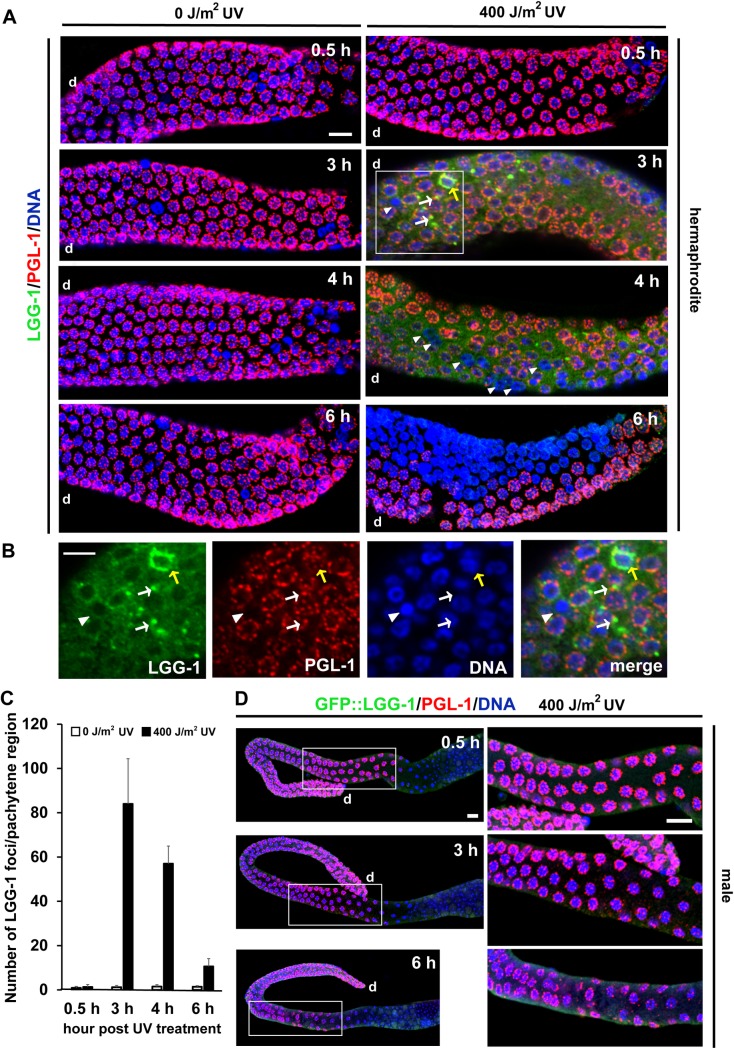
LGG-1 foci formation following UV irradiation in hermaphrodite and male gonads.(A) Confocal immunofluorescence images showing the time course of LGG-1 foci formation (green) and associated removal of PGL-1 (red) from germ nuclei (blue) in the pachytene region of N2 adult hermaphrodite gonads following 0 or 400 J/m2 of UV irradiation. More than 20 gonads were observed at respective time points under respective conditions. (0.5 h) Neither LGG-1 foci formation nor removal of PGL-1 was observed in the majority of germ cells in both the UV-irradiated and non-irradiated gonads. (3 h) A significant number of LGG-1 foci were observed in the cytoplasm and at the perinuclear region of germ cells (arrows in the inset), and PGL-1 started to disappear from some germ cells (an arrowhead in the inset) in the UV-irradiated gonad. The non-irradiated gonad appeared not different from the one at the 0.5 h time point. (4 h) The number of LGG-1 foci decreased compared to the 3 h time point, and PGL-1 was removed from a significant number of germ cells (arrowheads) in the UV-irradiated gonad. The non-irradiated gonad appeared not different from the ones at the 0.5 h and 3 h time points. (6 h) LGG-1 foci largely disappeared, whereas PGL-1 was lost from around 50% of germ cells (a cluster of blue germ nuclei) in the pachytene region of the UV-irradiated gonad. The non-irradiated gonad still appeared not different from the ones at the 0.5 h, 3 h, and 4 h time points. (B) The signals of LGG-1 (green), PGL-1 (red), and DNA (blue) in the inset (the area enclosed with a white square in the UV-irradiated 3 h gonad image) in (A) were enlarged and displayed separately along with their merged image for better appreciation of their localization and association in the area. The white arrows indicate LGG-1 foci that are located adjacent to PGL-1 granules. The yellow arrow indicates a cluster of LGG-1 foci that surround several PGL-1 granules. (C) Mean ± s.d. number of LGG-1 foci formed in the pachytene region of N2 adult hermaphrodite gonads at respective time points following 0 J/m2 (white bars) or 400 J/m2 (black bars) of UV irradiation. Number of analyzed gonads, n ≥ 20 for each time point and condition. (D) Confocal immunofluorescence images showing the equivalent time course of GFP::LGG-1 expression (green) and PGL-1 localization (red) in adult male gonads expressing a pie-1 promoter-driven GFP::LGG-1 transgene following 400 J/m2 of UV irradiation. Number of observed gonads, n = 15 for each time point. Left column, the entire gonads. Right column, enlarged pachytene region of respective gonads. Neither LGG-1 foci formation nor PGL-1 removal was observed in the pachytene region of male gonads following UV irradiation through the observation (0–6 h). d, distal side of each gonad. Scale bars, 20 μm.